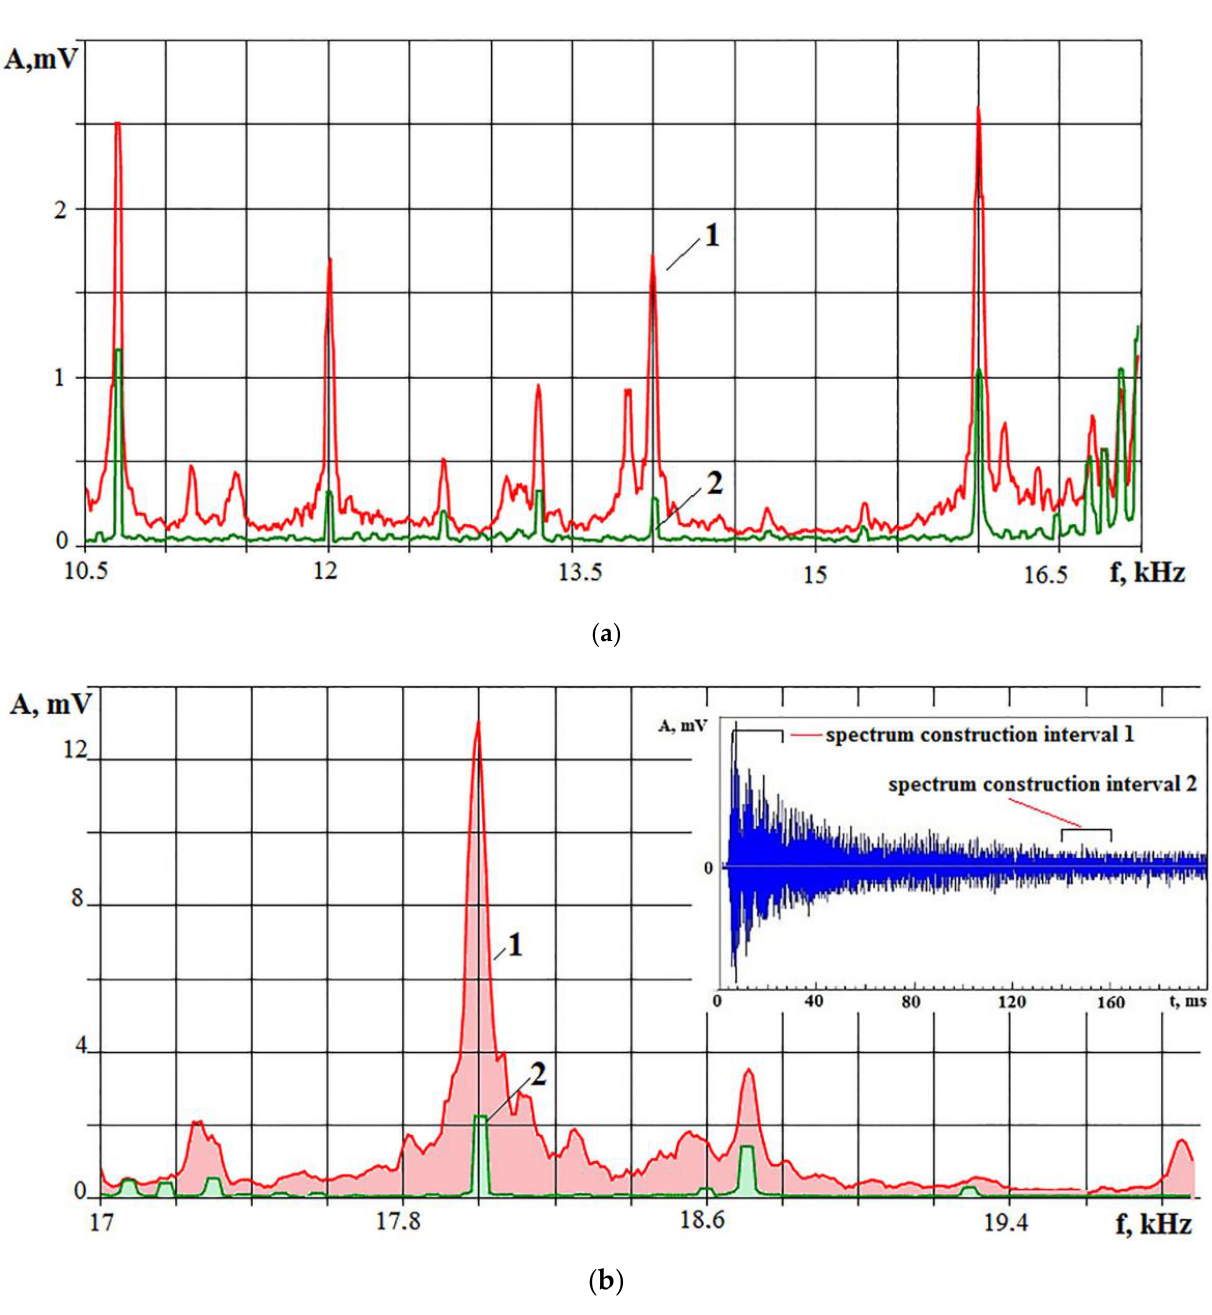
Figure 15. Comparison of AE signal spectra for the initial pulse period (spectrum 1) and after 140 ms (spectrum 2): ( a ) — spectra for the frequency range of 10 – 17 kHz; ( b ) — spectra for the frequency range of 17 – 20 kHz and recording of the AE signal with time interval marks for constructing spectra.